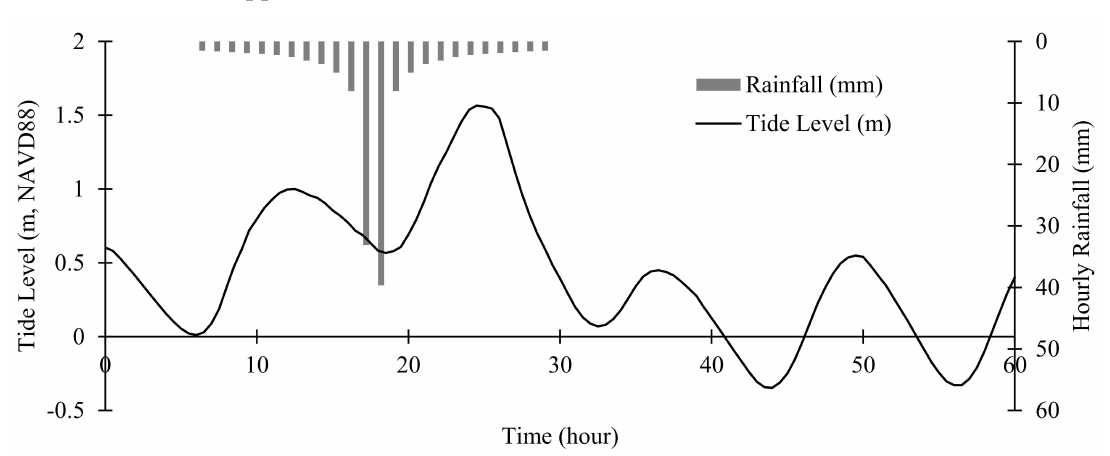
Figure A1. Designed combined storm scenario consists of a 10-year rainfall and a 10-year storm surge events. Note that the tide level is at the Sewells Point tide gauge in Norfolk,